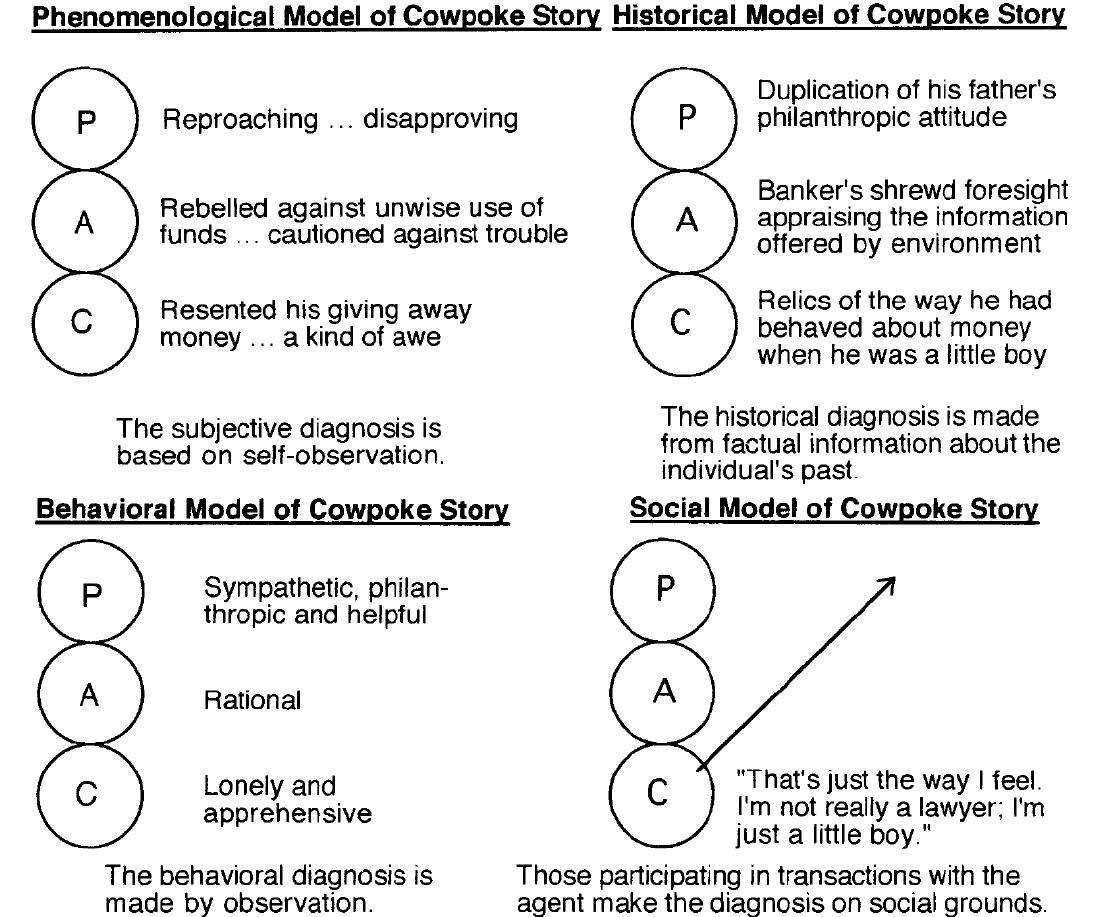
Figure 9: Ego State Models derived from the Four Paradigms of the Cowpoke Story (Drego, 1993, p.10)